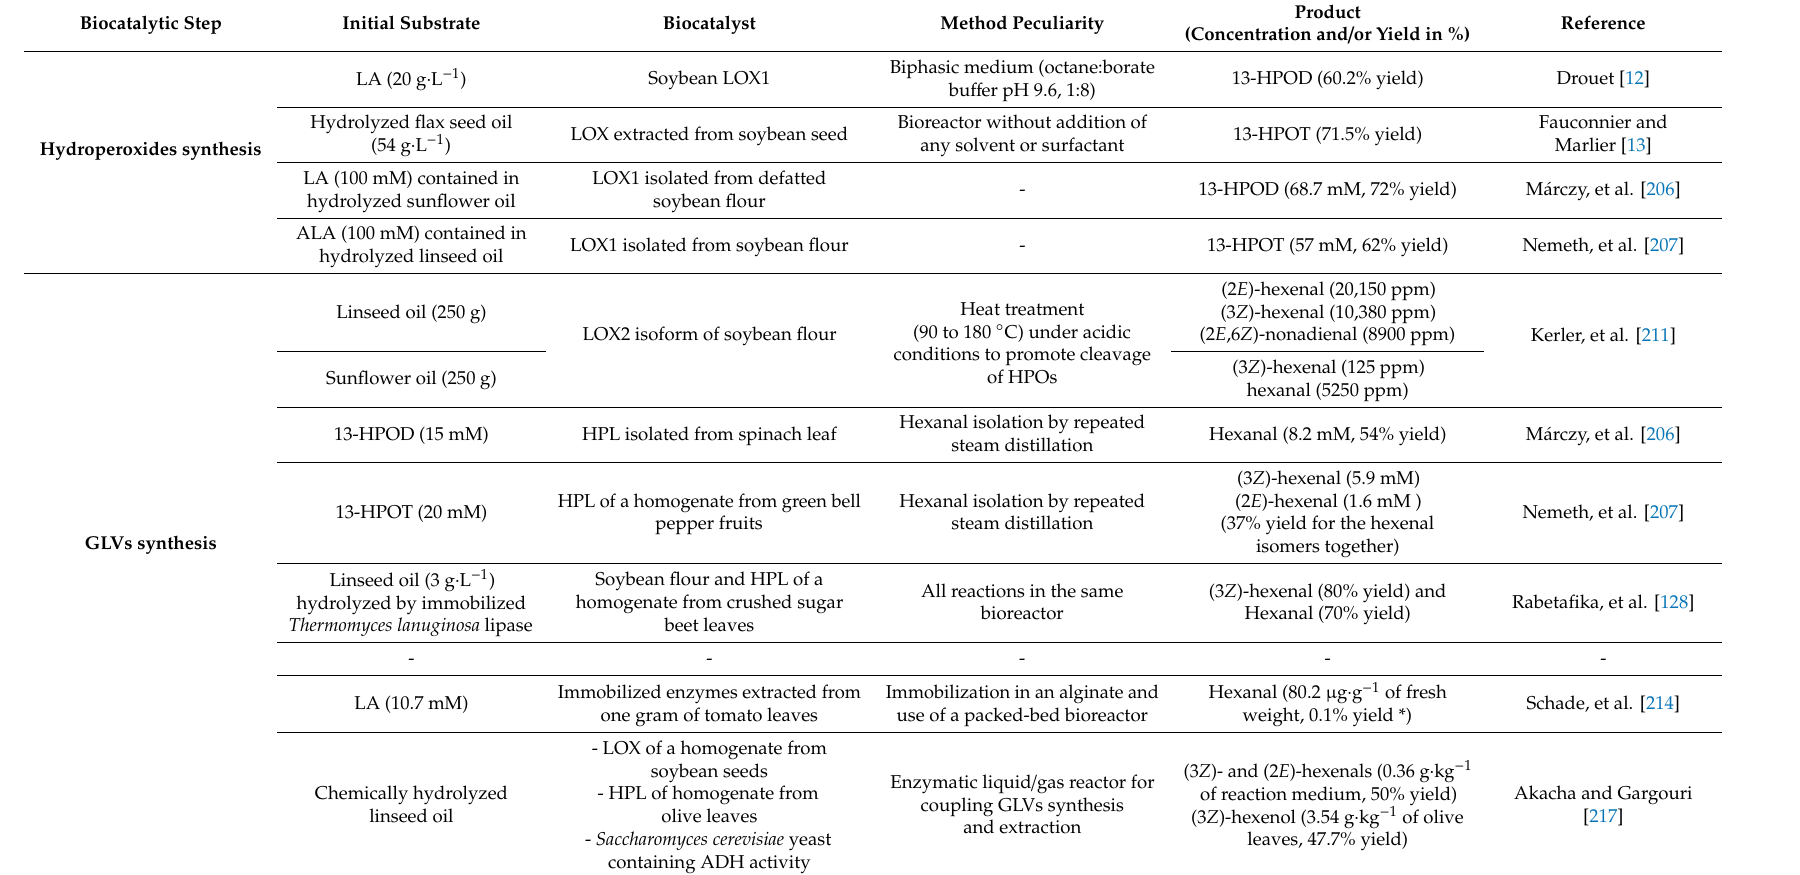
Table 2. Comparison of the methods used and the yields obtained for reactions of biotechnological